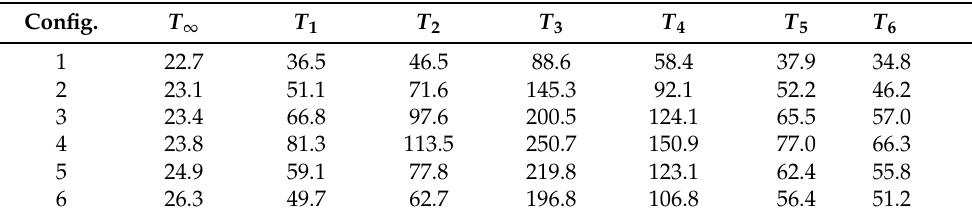
Table 3. Temperature measurement results from the wind tunnel experiments in [ ◦ C]. Config.